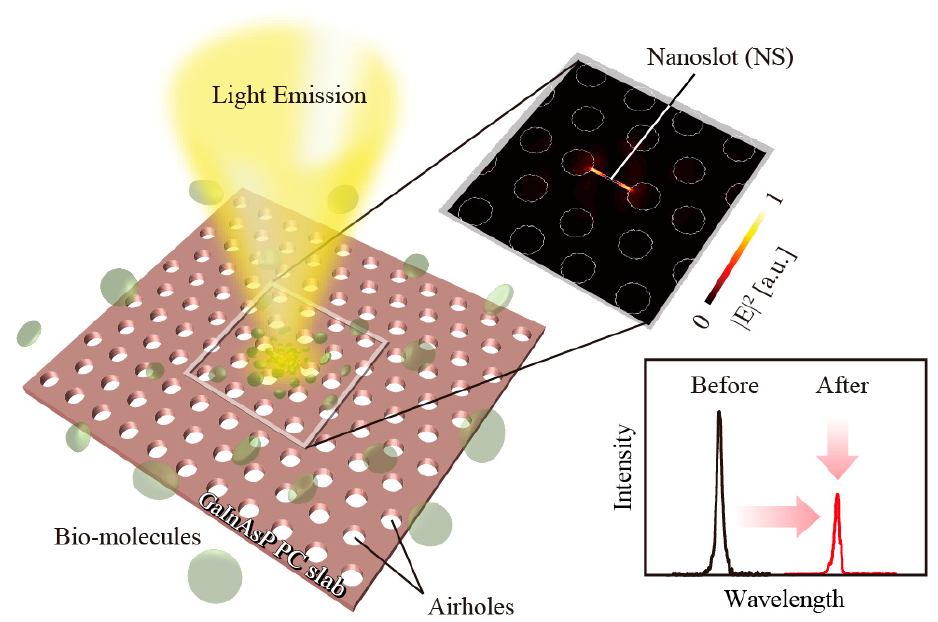
Figure 2. Schematic of GaInAsP PC nanolaser and its bio-sensing application. The magnified view of H0 type nanocavity with a nanoslot shows calculated distribution of modal electric field. Right lower figure schematically shows the laser wavelength before and after the sensing.